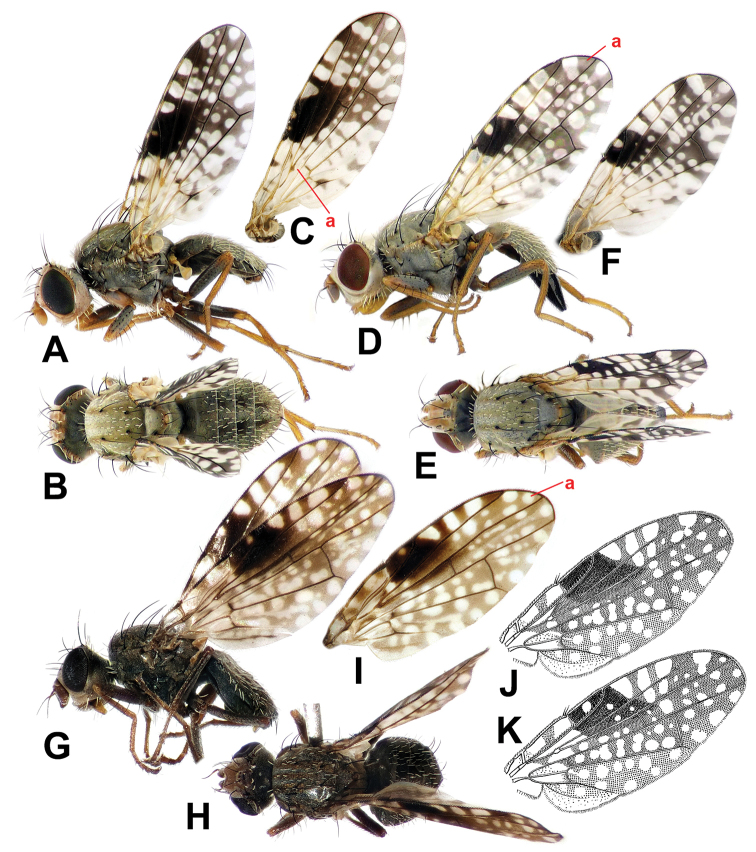
A–ECampiglossa
paramelaena sp. nov. A male, lateral view B male, dorsal view C male wing D female, lateral view E female, dorsal view F female, wing G–KC.
melaenaG male, lateral view H male, dorsal view I male, wing J holotype male, wing K female, wing J, K Reproduced from Korneyev and Ovchinnikova (2004) with permission from Valery Korneyev.